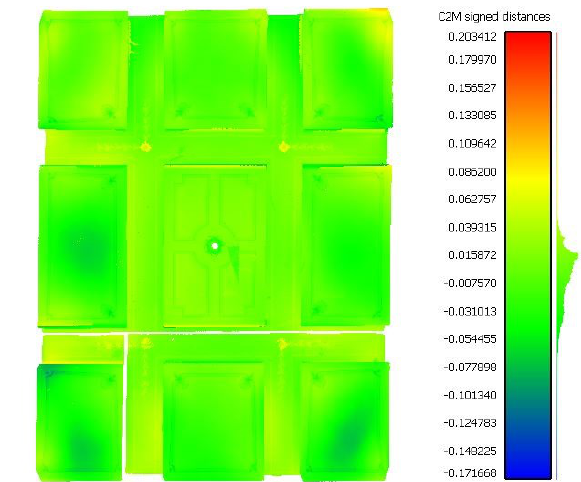
Figure 16. Distances between point cloud and ideal model. Processing: F.